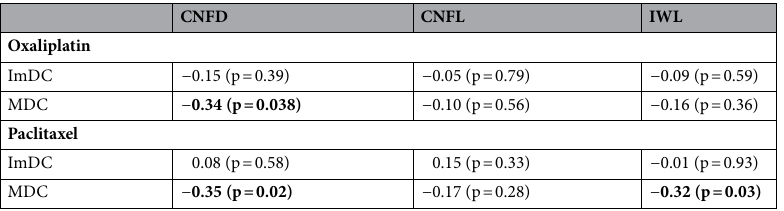
Table 3. Associations between dendritic cell densities and corneal nerve parameters for patients treated with oxaliplatin or paclitaxel. Data is reported as r (p-value) with statistically significant correlations highlighted in bold. ImDC immature dendritic cell density, MDC mature dendritic cell density, TotalDC total dendritic cell density, CNFD corneal nerve fiber density, CNFL corneal nerve fiber length, IWL inferior whorl length, ANFL average nerve fiber length.